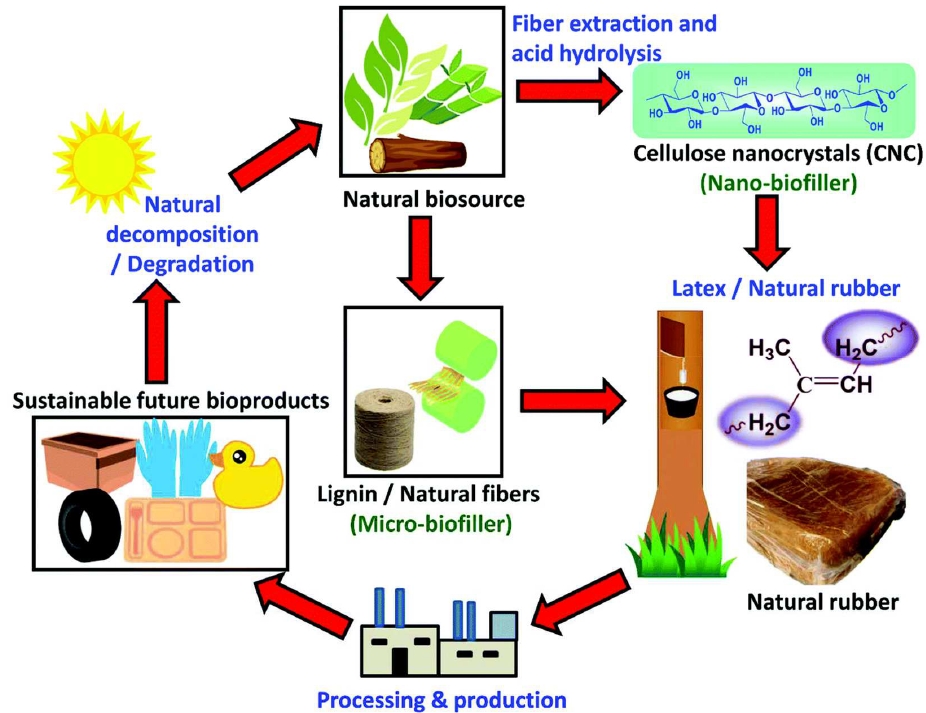
Figure 2. The incorporation of natural fiber in a rubber matrix promising a closed-loop sustainable approach for developing renewable and sustainable rubber. Reproduced with permission from [65]. Copyright 2021 The Royal Society of Chemistry.